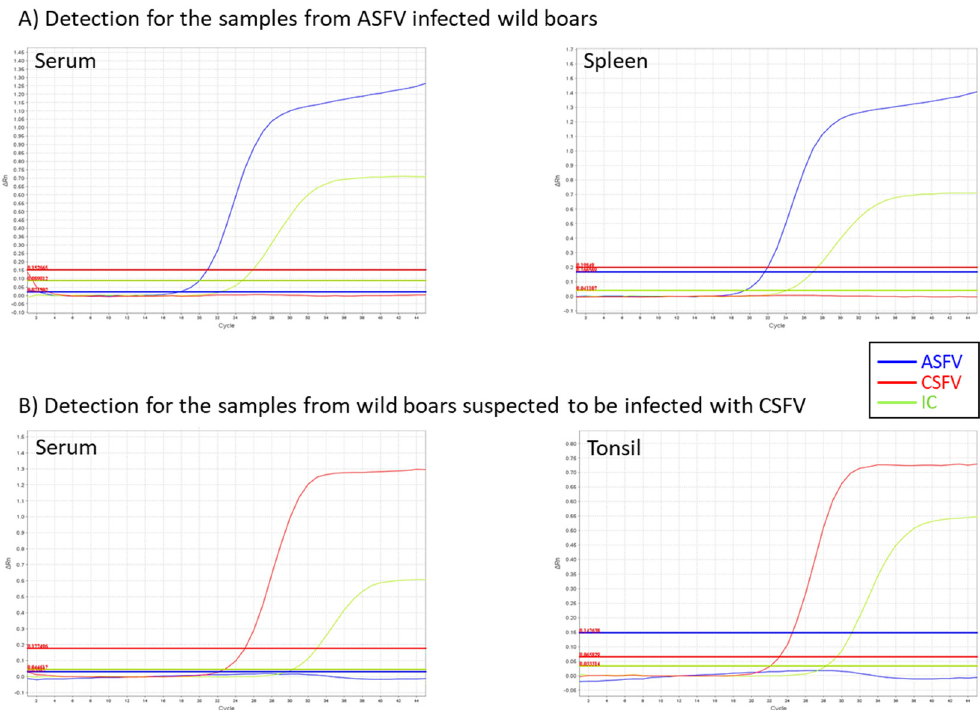
Figure 3. Outline of the direct-multiplex rRT-PCR system for the detection of ASFV and CSFV. The developed direct-multiplex rRT-PCR system requires only three steps to detect ASFV, CSFV, and IC.